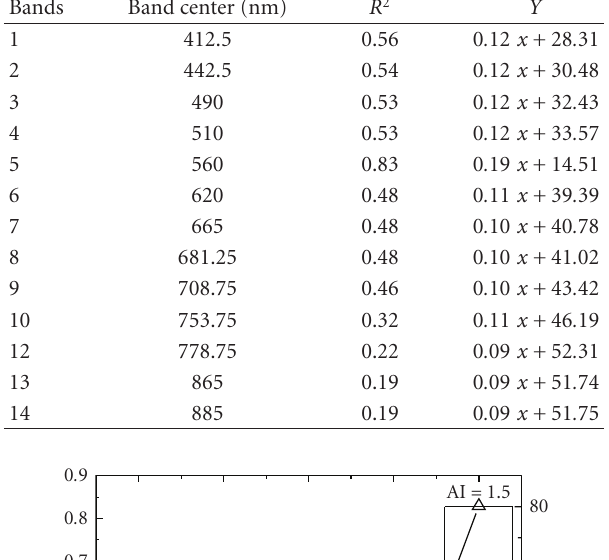
Table 2: Performance of DTA code on each of the available MERIS spectral bands expressed in terms of correlation between satellite- based AOD and ground-based aerosol (PM 10 ) measurements. Y : PM 10 ( μ grcm − 3 ), X : AOD( × 10 3 ).